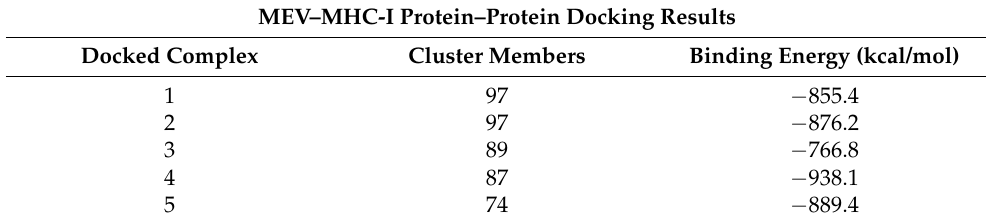
Table 3. Molecular docking results of MEV construct with MHC-I and MHC-II molecules.